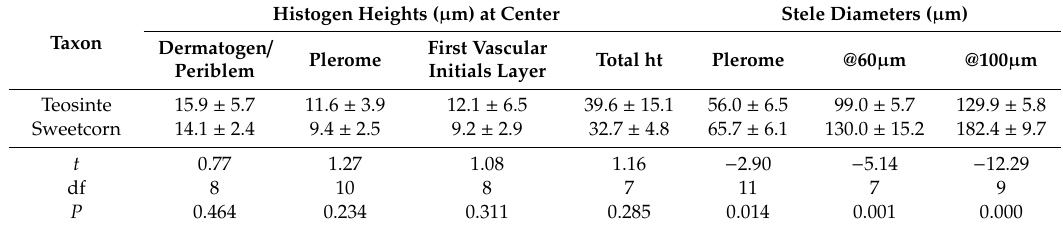
Table 1. Structural data from primary root apical meristems (promeristems) of teosinte ( Zea mays ssp. mexicana ) and sweetcorn ( Z. mays ‘Honey Bantam’) 3–4 d after germination in moist vermiculite (means ± std. dev., n = 7 each). Stele diameters are shown at the plerome and at fixed distances from the root cap junction. All teosinte stele diameters were significantly di ff erent ( t -test, p = 0.05) than sweetcorn. Histogen heights were not significantly di ff erent ( t -test, p = 0.05) between the taxa (statistics comparing column values are below each column).